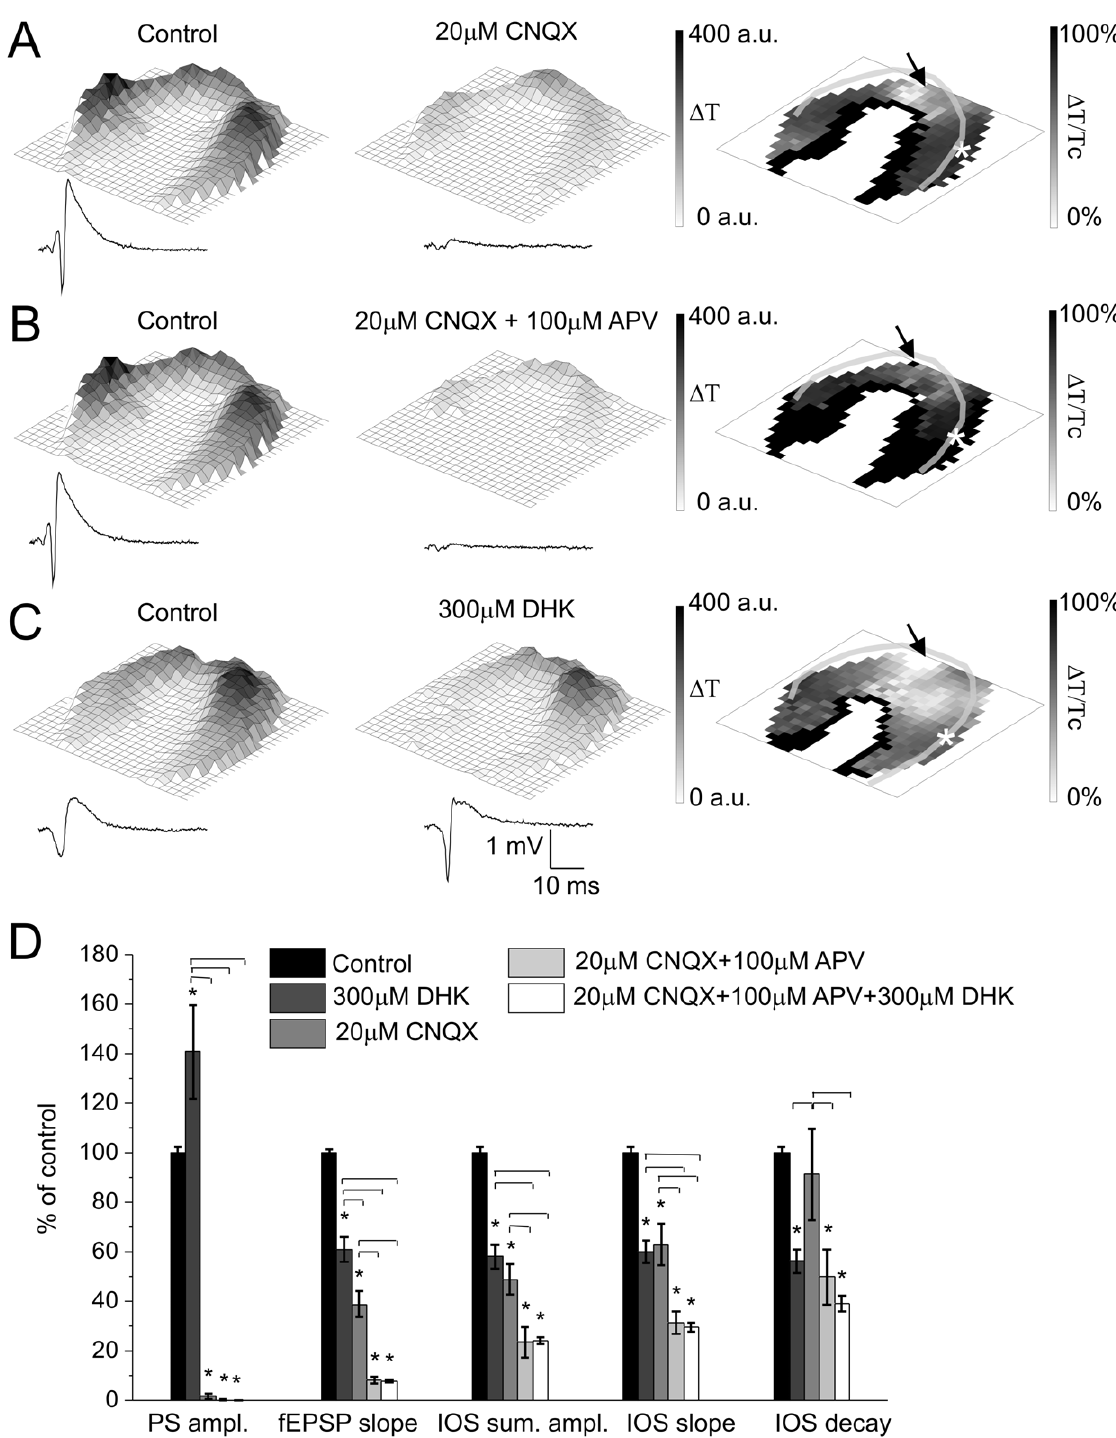
Figure 4. Ionotropic glutamate receptors and glial glutamate uptake plays a role in IOS. A Left and Middle: Representative IOS amplitude map and field response curve under control condition and under application of 20 m M CNQX, respectively. The colorbar indicates the maximum change of the transmittance compared to the resting light intensity. A Right: Spatial visualization of the percentage of control changes of IOS signal caused by CNQX application. B Left and Middle: Representative IOS amplitude map and field response curve under control condition and under application of 20 m M CNQX in combination with 100 m M APV, respectively. The colorbar indicates the maximum change of the transmittance compared to the resting light intensity. B Right: Spatial visualization of the percentage of control changes of IOS signal caused by APV and CNQX application. C Left and Middle: Representative IOS amplitude map and field response curve under control condition and 300 m M DHK application, respectively. The colorbar indicates the maximum change of the transmittance compared to the resting light intensity. C Right: Spatial visualization of the percentage of control changes of IOS signal caused by DHK application. D: Effect of 300 m M DHK and 20 m M CNQX alone and 20 m M CNQX in combination with 100 m M APV or 100 m M APV and 300 m M DHK on the field response and IOS parameters in percentage of control.